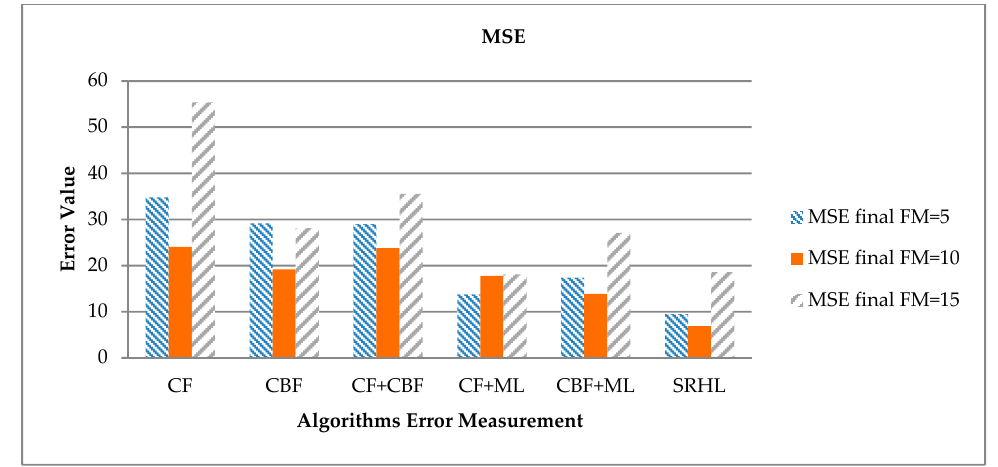
Figure 10. Each experiment’s MSE results. Table 6. Formulas of MAE, MAPE, and MSE evaluation